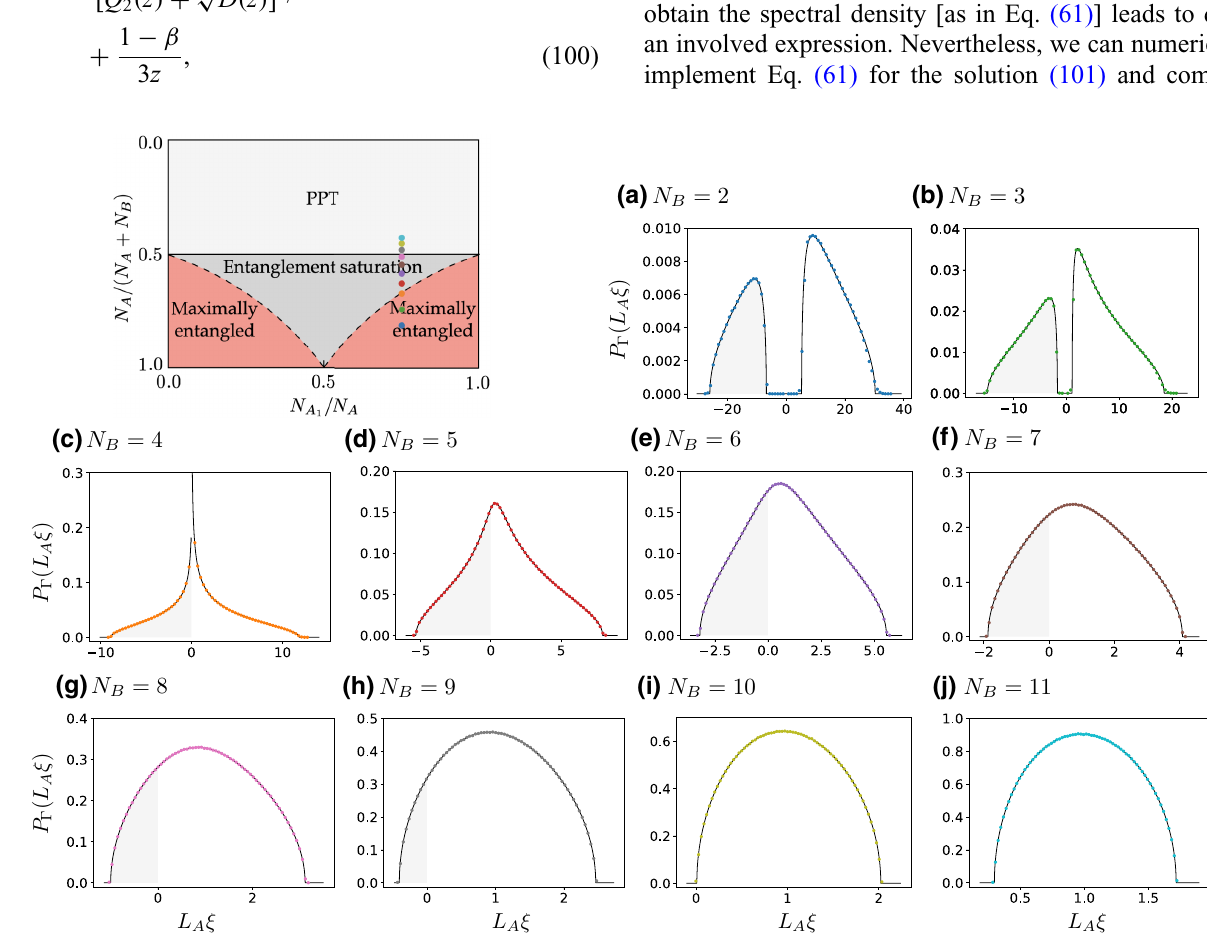
FIG. 7. Evolution of the negativity spectrum as the size of subsystem B is increased. This trend corresponds to sweeping a vertical path from bottom to top in the phase diagram as shown in the first panel. The color circles in each panel are numerical simulations (averaged over 10 4 samples) and solid lines correspond to Eq. (101). Here, we set N A the domain of negative eigenvalues. Two transitions occur as we crank up N B : First, the transition from maximally entangled to a saturated entangled state at N B = 4, characterized by diverging spectral density at ξ = 0, second, the NPT to PPT transition at N B = 10 where the semicircle’s support becomes completely